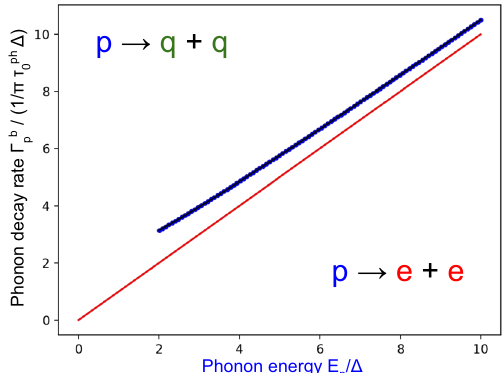
Fig. 2 Quasiparticle scattering rate. Plot showing the quasiparticle decay rate versus energy Eq. (4) (black dots), along with a fi t formula Eq. (5) (blue line); the corresponding rate for a normal metal is the red line. The rates scale approximately as the fi nal phonon density of states.